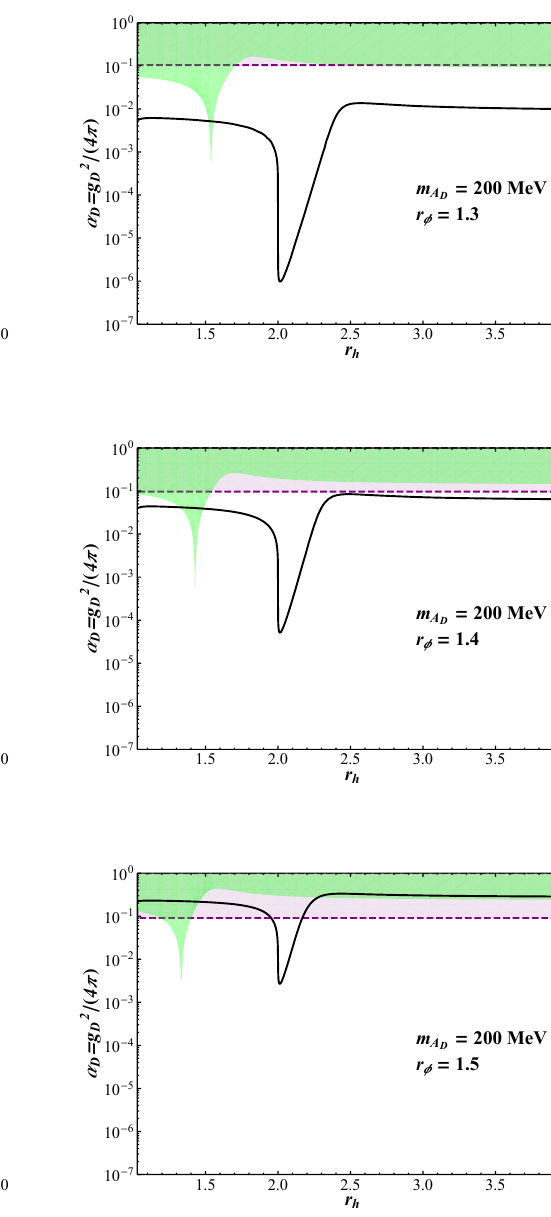
Figure 13. Contours in the α matter relic abundance assuming b = 1 and (cid:15) = 3 excluded by CMB limits on ( σv ) ISR [46] are depicted as a green shaded region, while projected constraints from a null result of SENSEI after 100 g shaded region with a dashed